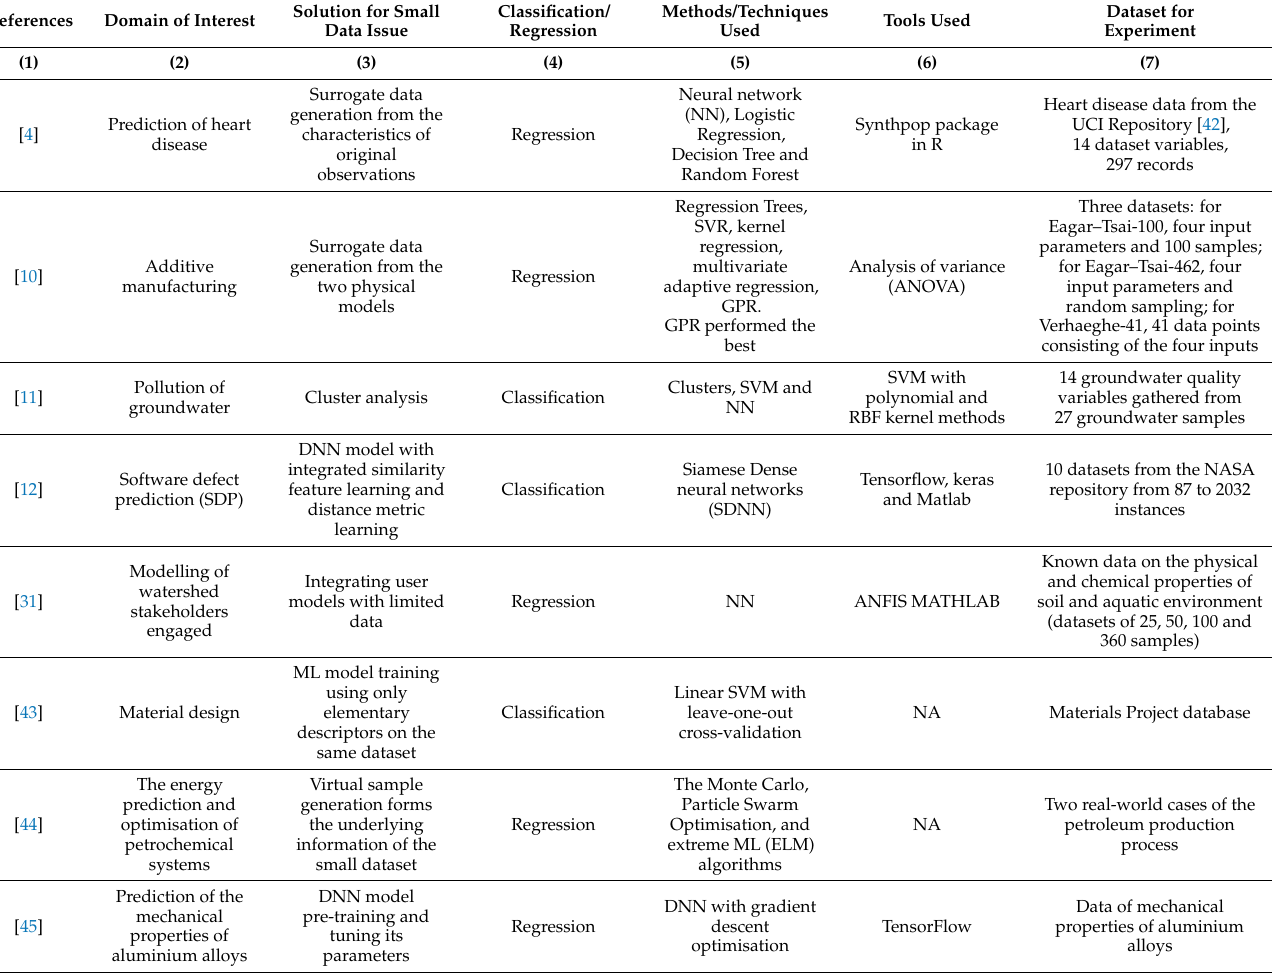
Table 1. Comparison of approaches, methods, and techniques used in ML to solve issues caused by small